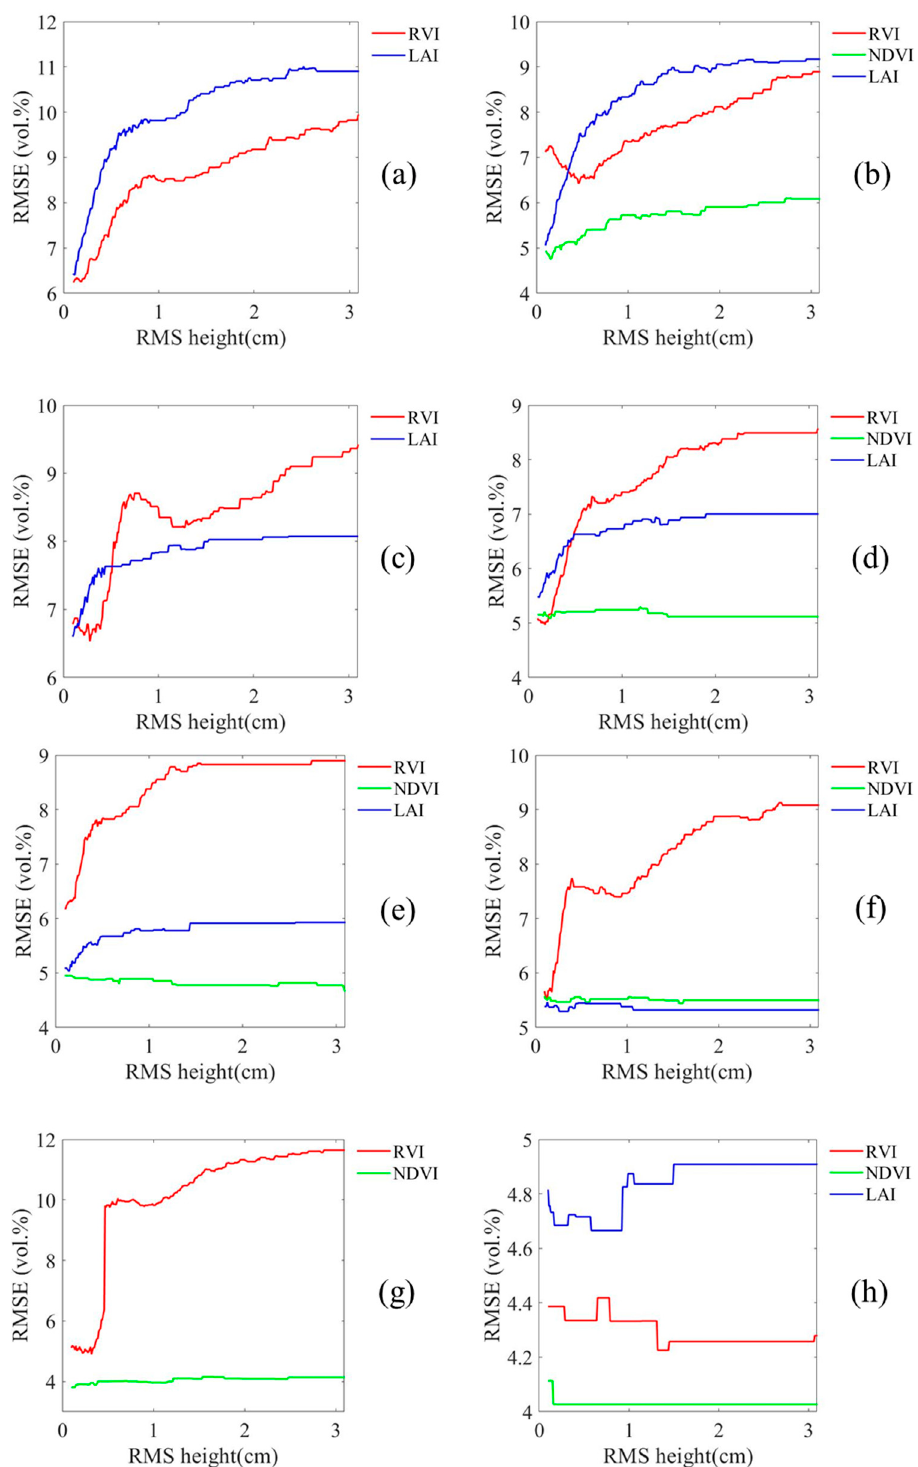
Figure 5. SMC estimation accuracy on training set with different roughness parameters (WCM), ( a )